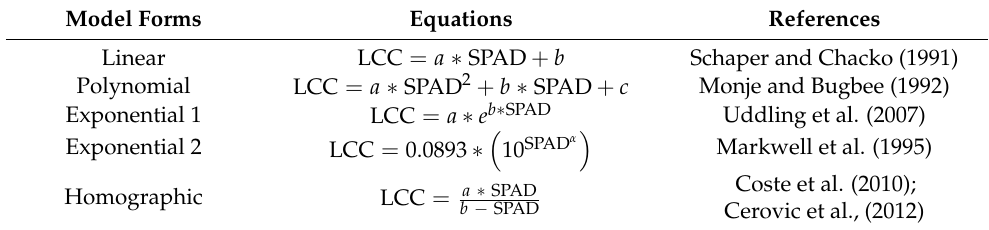
Table 3. The commonly used functions for estimating leaf chlorophyll content (LCC in the unit of µ g cm − 2 ) from SPAD